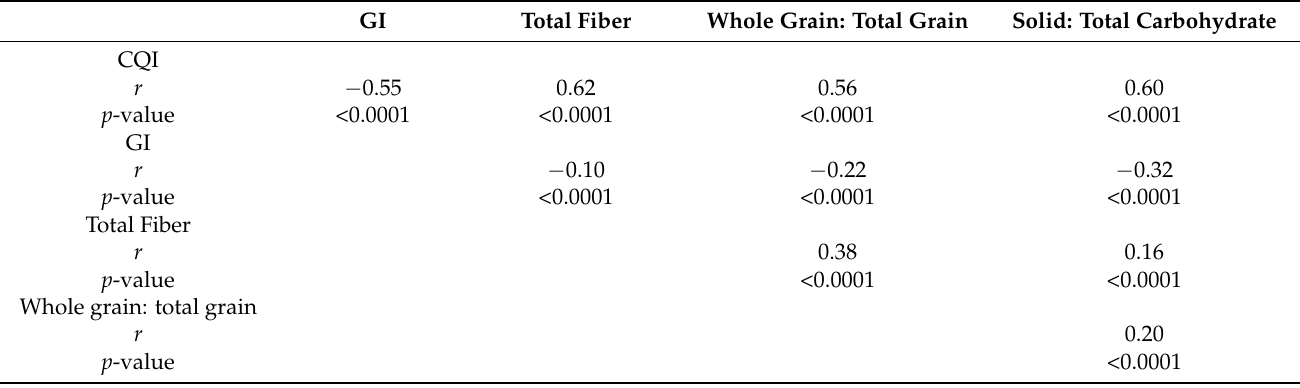
Table 3. Spearman correlation coefficients between CQI and its component factors.